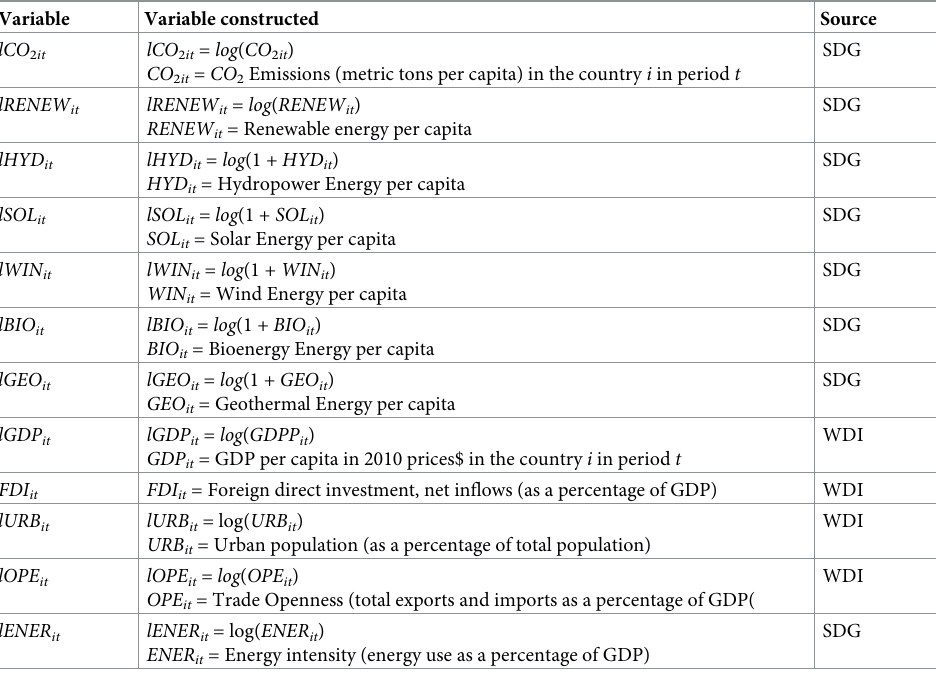
Table 1. Variables